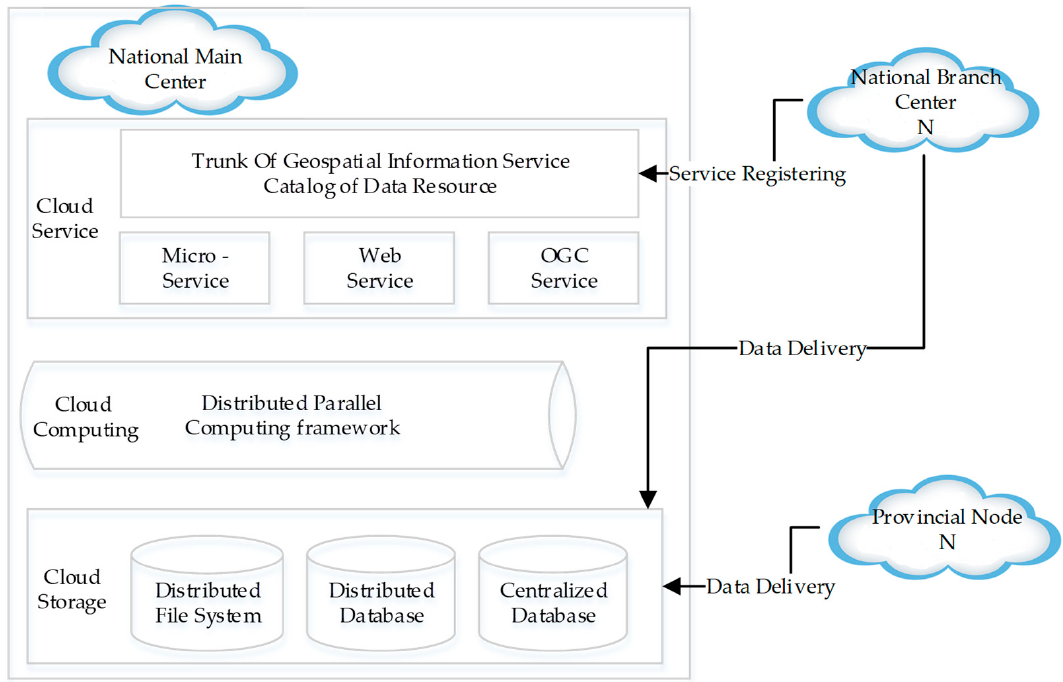
Figure 3. Technology architecture of basic information platform of territorial space.